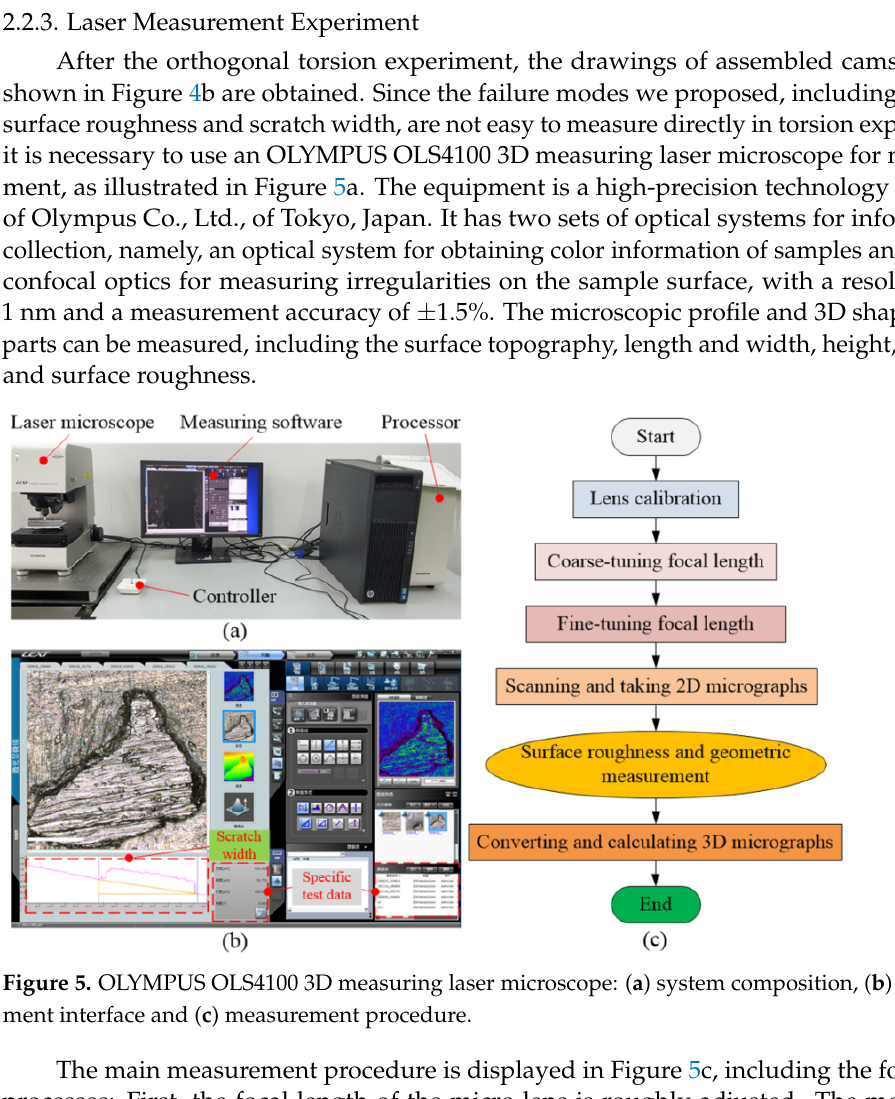
Figure 4. Drawing of a partially assembled camshaft [28]: ( a ) before torsion and ( b ) after torsion.